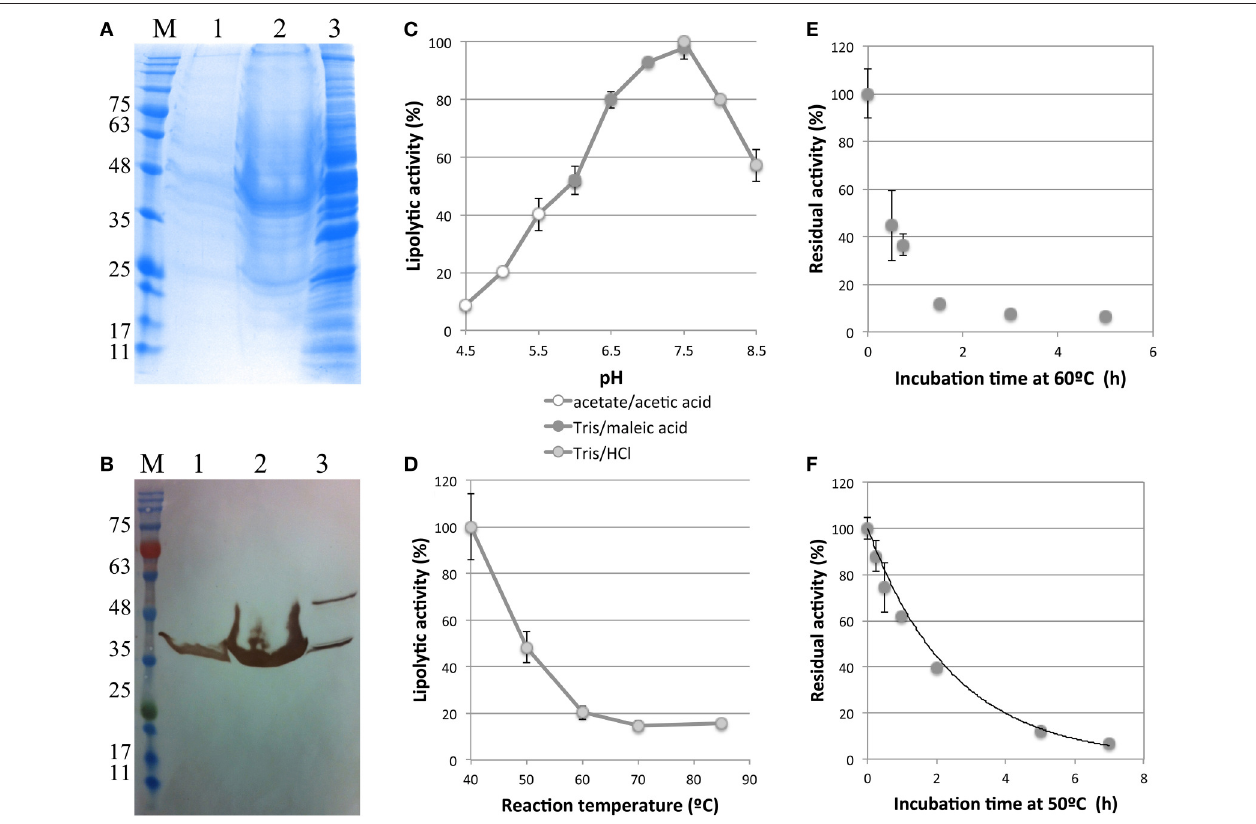
FIGURE 7 | Biochemical characterization of LOB4Est: analysis by SDS-PAGE, Coomasie stain (A), and Western Blot, anti-FLAG-M2 monoclonal antibody (B), of different fractions from a culture of Sc-LOB4Est strain: 1-supernatant, 2- 8 × concentrated supernatant, 3-crude extract. M: NZYcolour Protein Marker II (ENZYTech). Relative activity of the recombinant enzyme at different values of pH (C) and temperature (D) . Data show mean ± standard deviation. N = 3 . Residual activity of recombinant enzyme after incubation at 60 ◦ C (E) and 50 ◦ C (F) and first-order model of thermal deactivation at 50 ◦ C. Data show mean ± standard deviation. N = 3